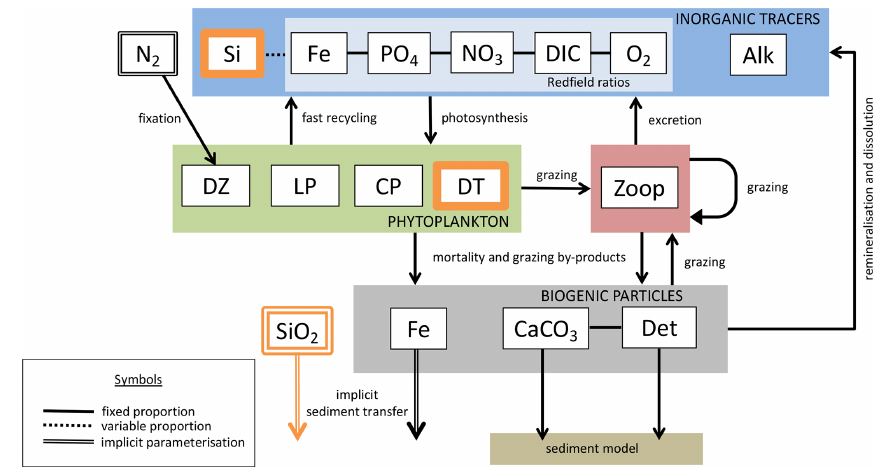
Figure 1. The latest biogeochemical model structure for KMBM3. Previously unpublished features are shown in orange. Table 2. Miscellaneous KMBM3 parameters. Parameter Symbol